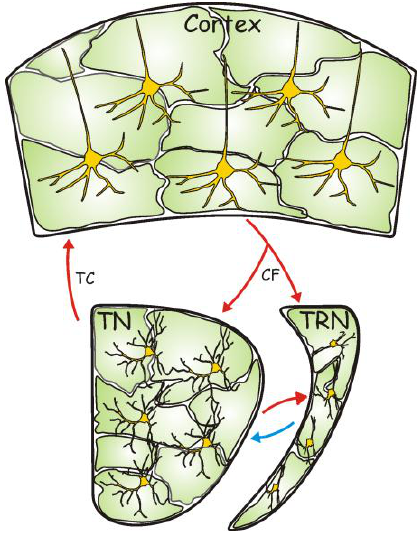
FIGURE 3. Slow oscillation generation: an integrated circuit view. Intracortical circuits are fundamental and sufficient to generate slow oscillations. Nonetheless, slow oscillations are likely influenced by the activity of the thalamic nucleus (TN) and the thalamic reticular nucleus (TRN), the targets of corticofugal fibers (CF). The coordinated activity of these two thalamic structures can then modulate cortical activity through the thalamocortical (TC) projections innervating cortical layer IV. We propose that slow oscillations result from the integrated activity of the glial (green cells) and neuronal (yellow cells) networks in the thalamocortical loop. Red and blue arrows indicate excitatory and inhibitory synaptic connections,